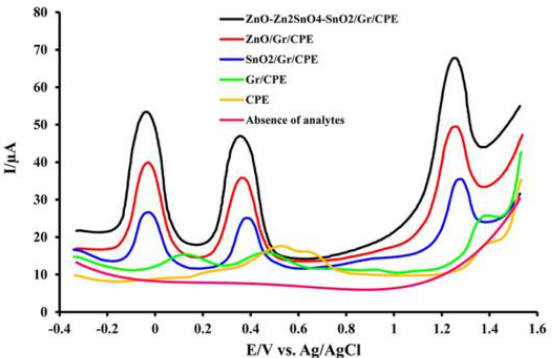
Figure 5. DPV of the bare CPE, Gr/CPE, SnO2/Gr/CPE, ZnO/Gr/CPE, and ZnO-Zn2SnO4-SnO2/Gr/CPE in the presence of 7.0 µM AA, 5.0 µM AC, and 6.0 µM CF, and ZnO-Zn2SnO4-SnO2/Gr/CPE in the absence of the analytes. Reprinted from [75].